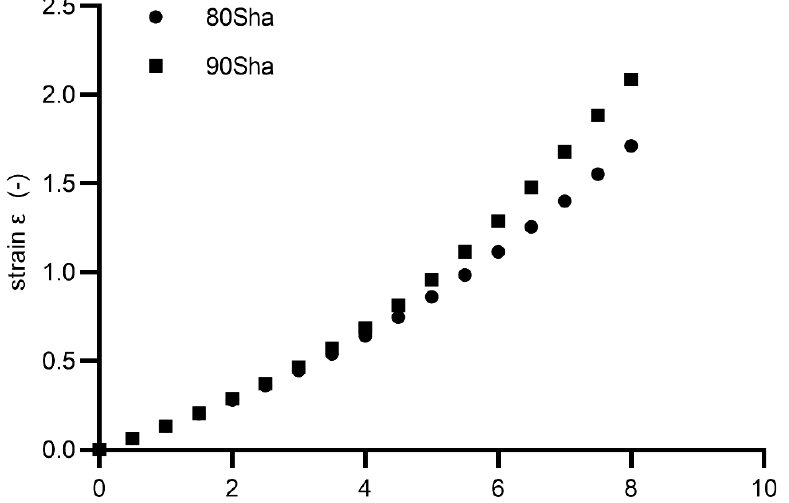
Figure 14. Nominal strain vs. displacement for diabolo specimens used in the experimental campaign.